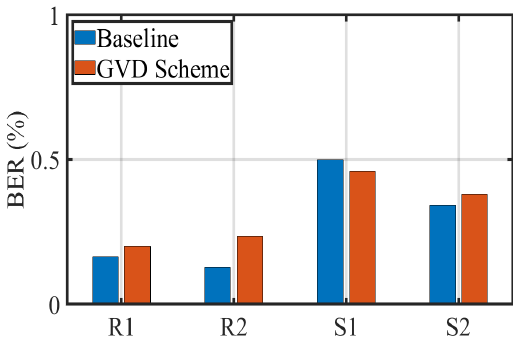
Figure 10. BER with variable LED shape and size.